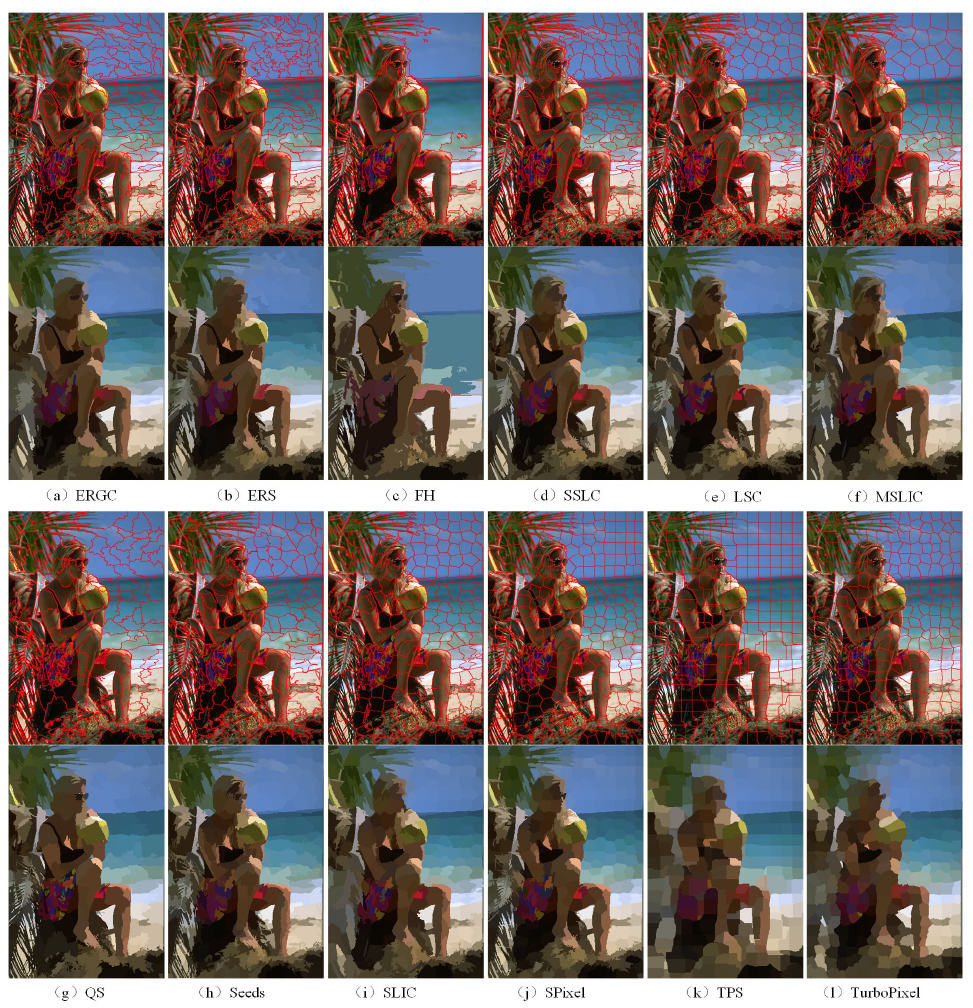
Figure 7. Superpixels obtained by all tested superpixel algorithms in an example image with heterogeneous contents and scene layouts. The top and third rows are the results of various superpixel algorithms, and the second and bottom rows are region mean images corresponding to the superpixel segmentations in the top and third